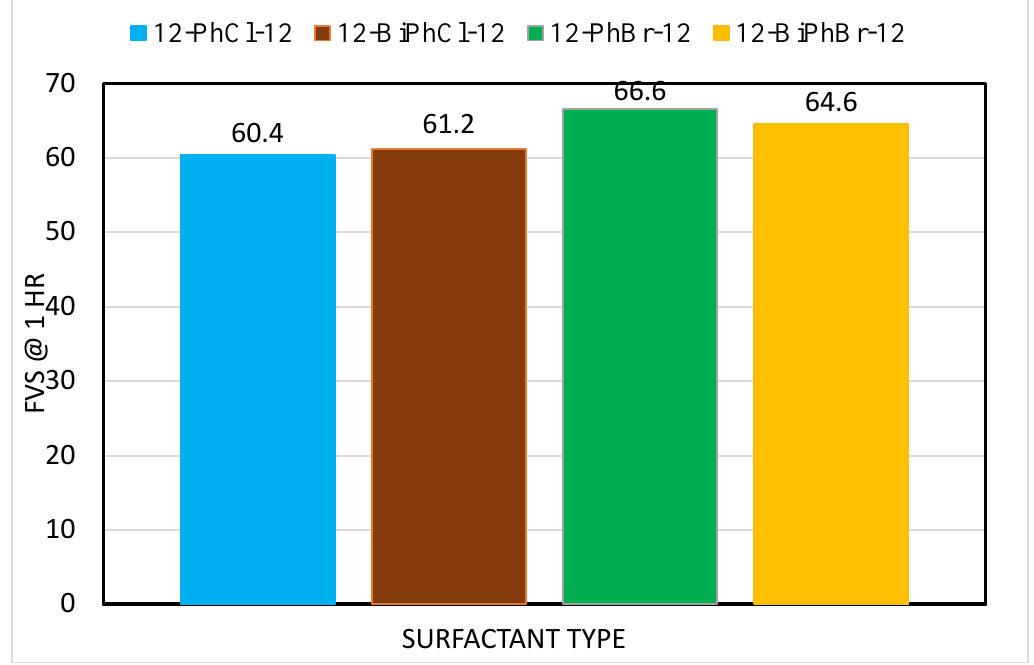
Figure 3. Comparison of foam volume stability (FVS) of different surfactants at the same concentration (0.5 mM).